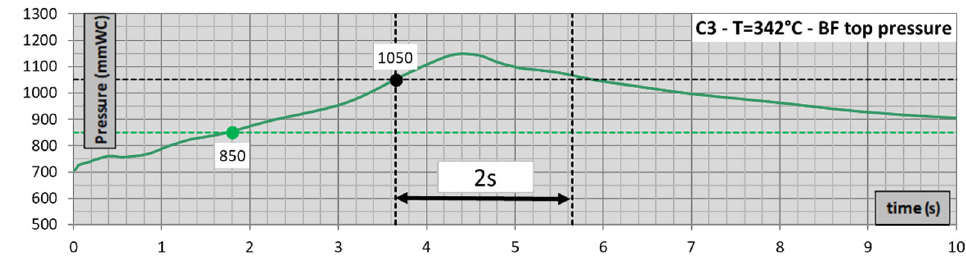
Figure 15. Evolution over time of pressure in circuit C3.